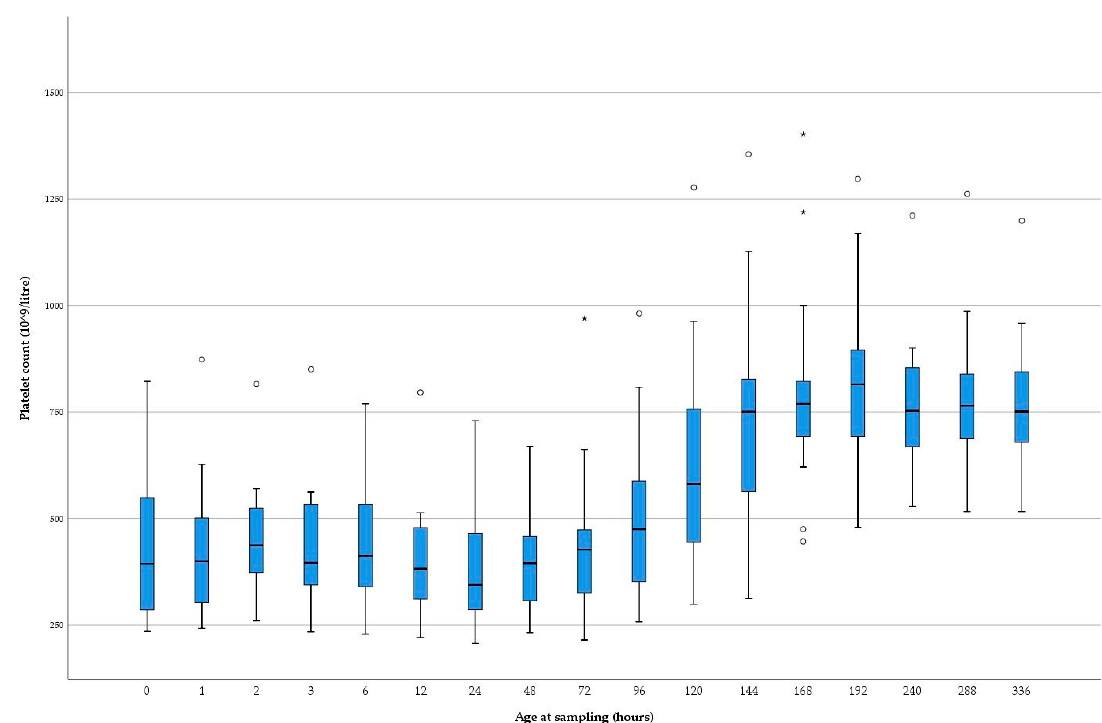
Figure 2. Boxplots of platelet counts ( × 10 9 /L) per sampling point in the longitudinal study. Blue box representing the central 50% of the platelet counts. The median is marked by the horizontal black line inside of the blue box. The whiskers define the 2.5th and 97.5th percentiles. ◦ = outlier outside the ranges 3rd quartile + 1.5 × interquartile range or 1st quartile–1.5 × interquartile range. * = outlier outside the ranges 3rd quartile + 3 × interquartile range.